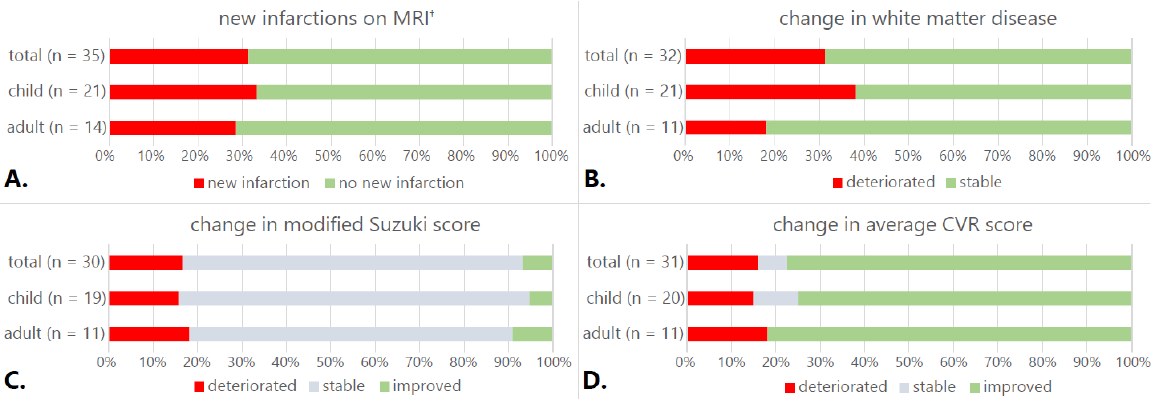
Figure 2. Change in imaging scores. ( A ) New infarctions on the MRI one year after the last operation. ( † ) Three adults did not receive a scan at follow-up but received an MRI shortly after the operation and are included in this graph. ( B ) Change in average white matter disease. ( C ) Change in modified Suzuki score (mSS). ( D ) Change in average cerebrovascular reactivity (CVR) score.